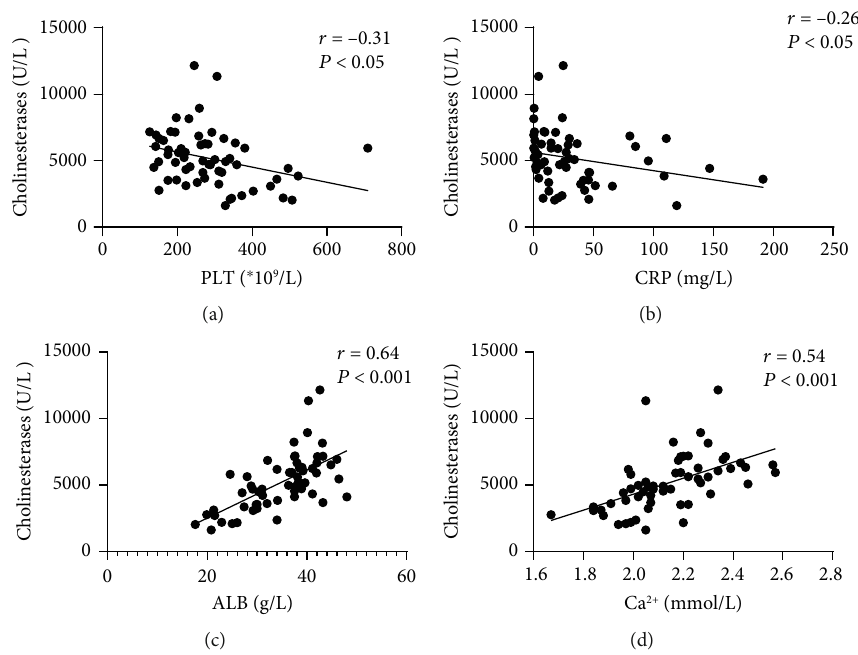
Figure 3: The correlation between serum ChE levels and (a) PLT, (b) CRP, (c) ALB, and (d) Ca 2+ level in CD patients by using a scatter plot.